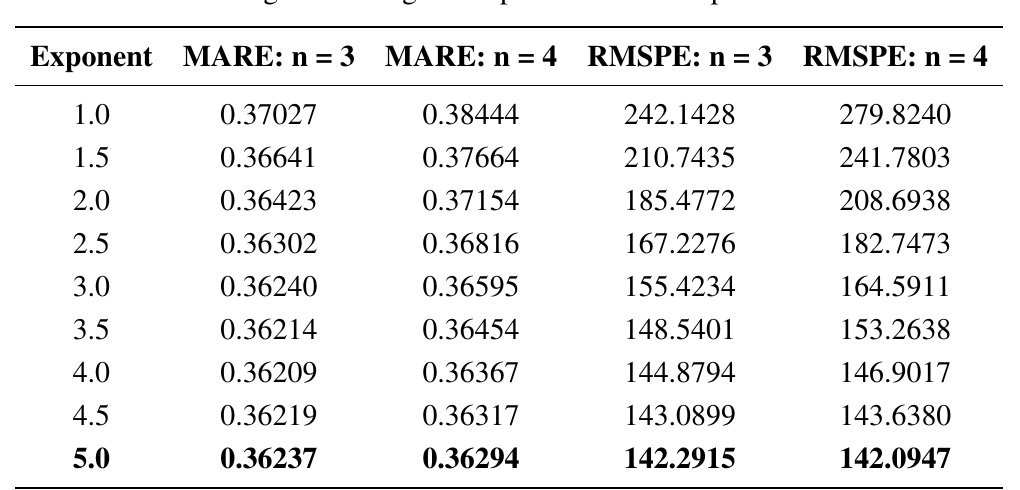
Table 3. MARE and RMSPE LOOCV results for nine IDW methods with a maximum of three and four nearest neighbors using the improved IDW